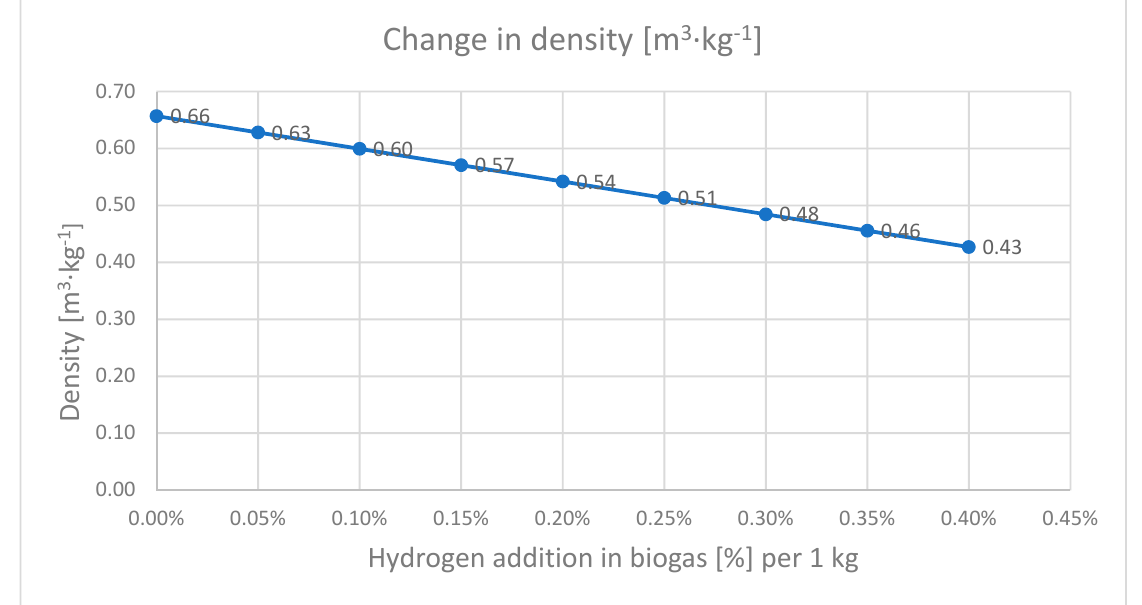
Figure 8. Change in gas density as a function of hydrogen mass content .